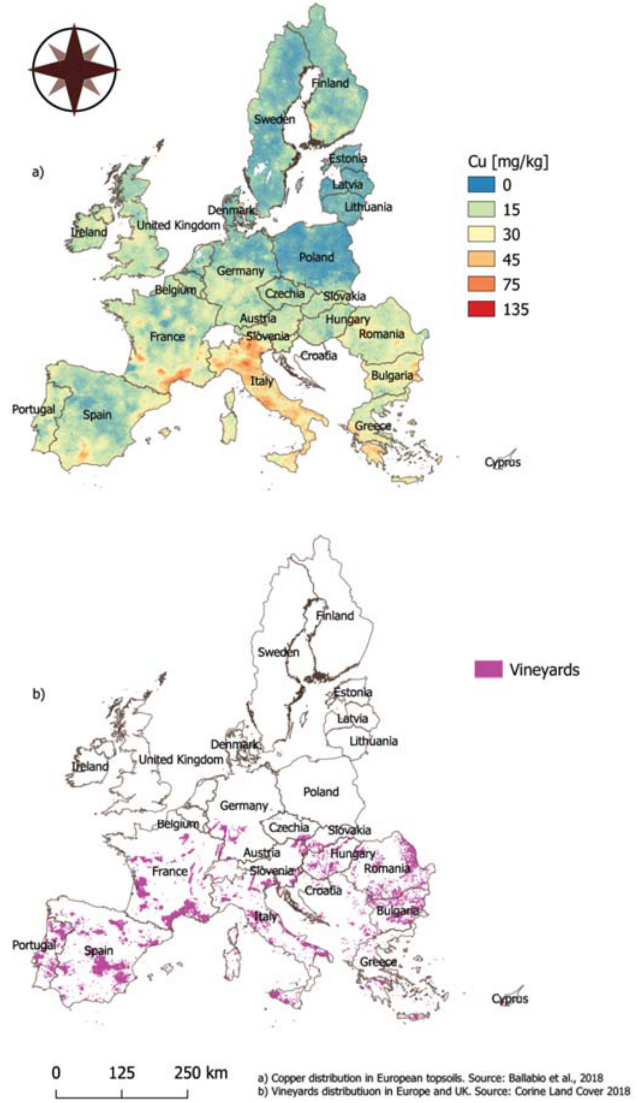
Figure 1. Cu concentration distribution ( a ) compared to the distribution of vineyards ( b ) in Europe [42]. Several high Cu concentration areas perfectly match viticulture areas.